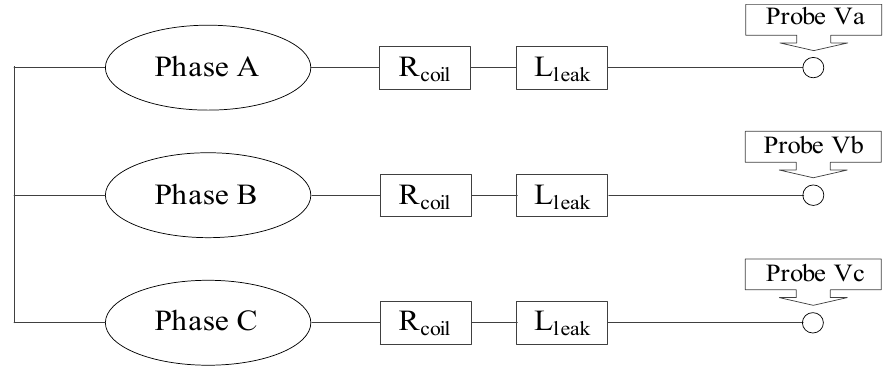
Figure 6. Cross-section of permanent magnet synchronous motor.